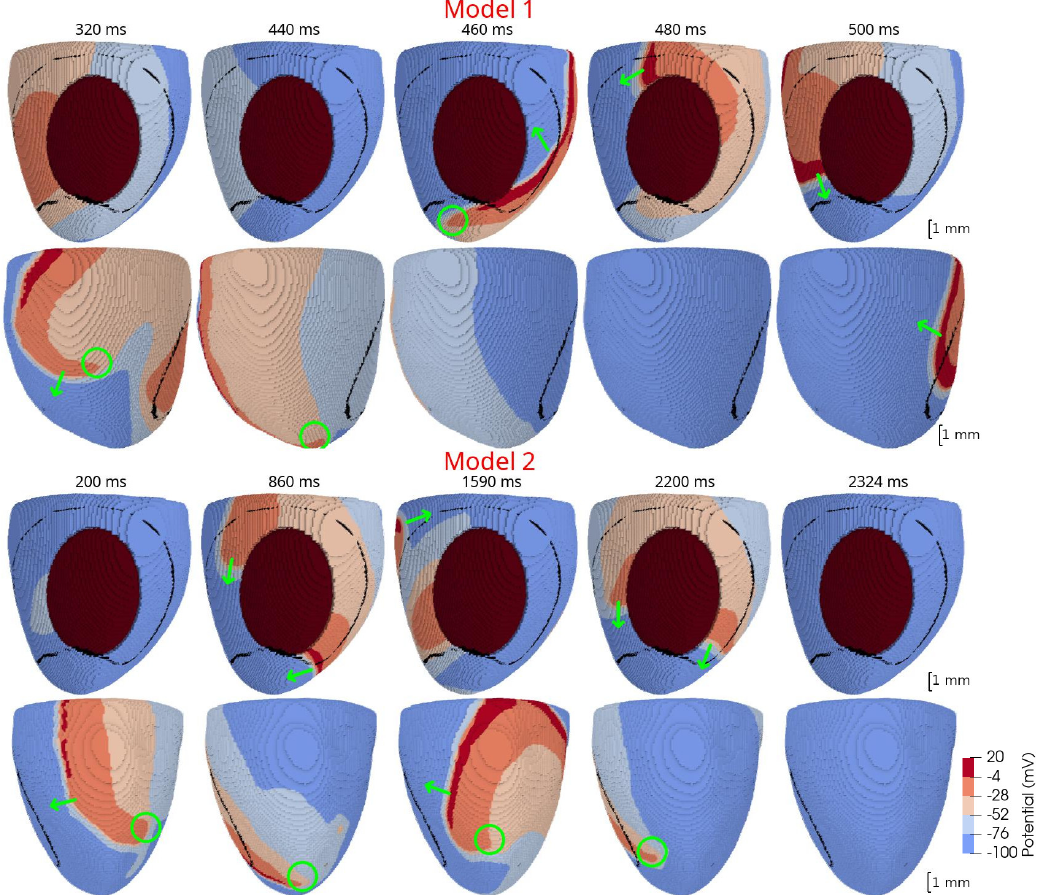
Figure 10. Dynamics of scroll waves initiated away from the scar. The notations are the same as in the previous figures. Color scale for transmembrane potential is given on the bottom right. Green circles indicate the position of the spiral wave tip until the wave is anchored around the obstacle (for Model 1). Green arrows indicate local directions of the wave